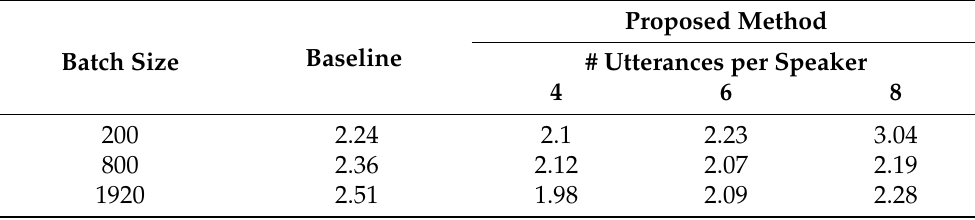
Table 5. Performance comparison of the baseline and proposed framework according to the batch size and number of utterances per speaker on the Voxceleb1 test